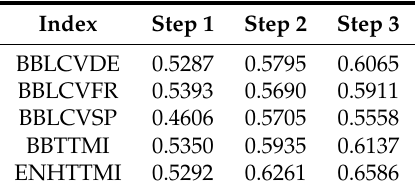
Table 12. Comparison of the ratios of RMSE for models for capital goods with an expanding window from 2008:01 to